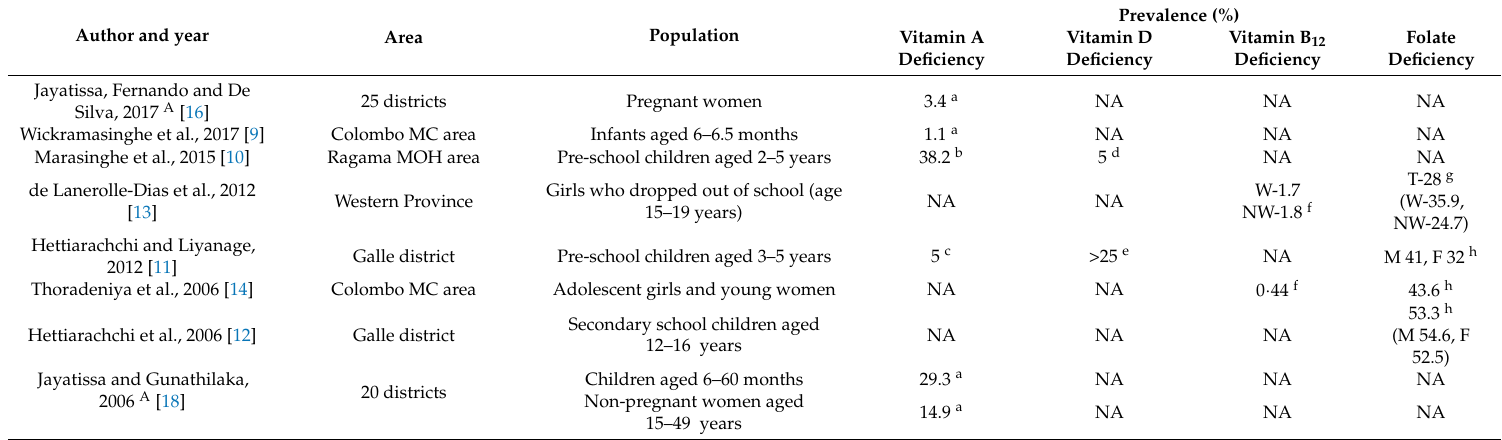
Table 8. Prevalence of vitamin deficiencies in Sri